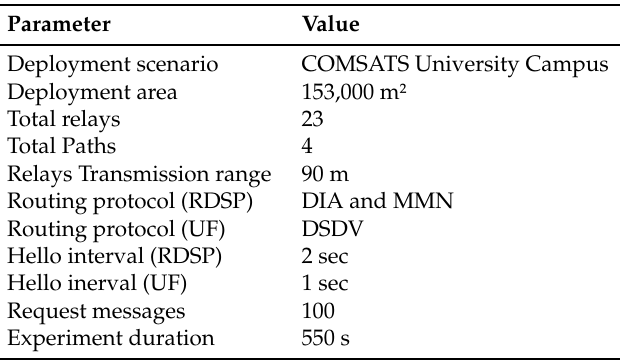
Figure 8. Deployment of the RDSP system. Table 1. Experimental